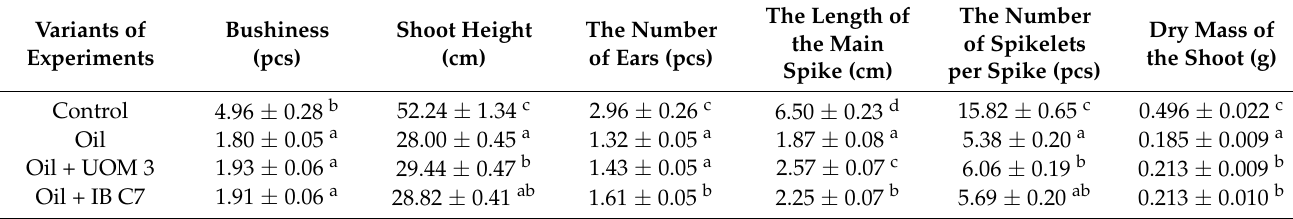
Table 2. The influence of oil pollution and treatment with bacteria on some indicators of growth and development of barley plants at the end of the experiment.